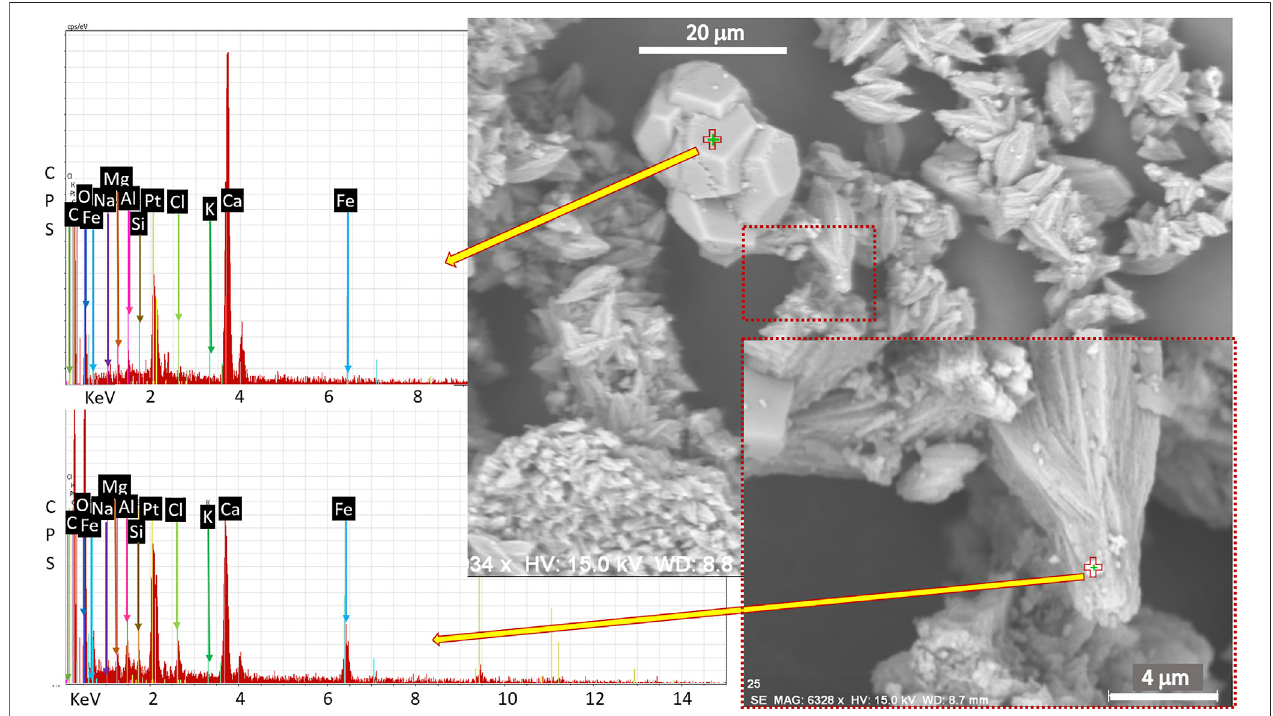
FIGURE 8 | Backscatter SEM image of sample ES25 with EDS of points indicated by red and green crosses. The small, bright grain agglomerate on the tip of the aragonite crystal is enriched in iron and not enriched in aluminum with respect to the underlying phase (data not shown). The energies of both identi fi ed elements and those searched for but not identi fi ed are indicated on the plot. Pt is used to coat the sample for better